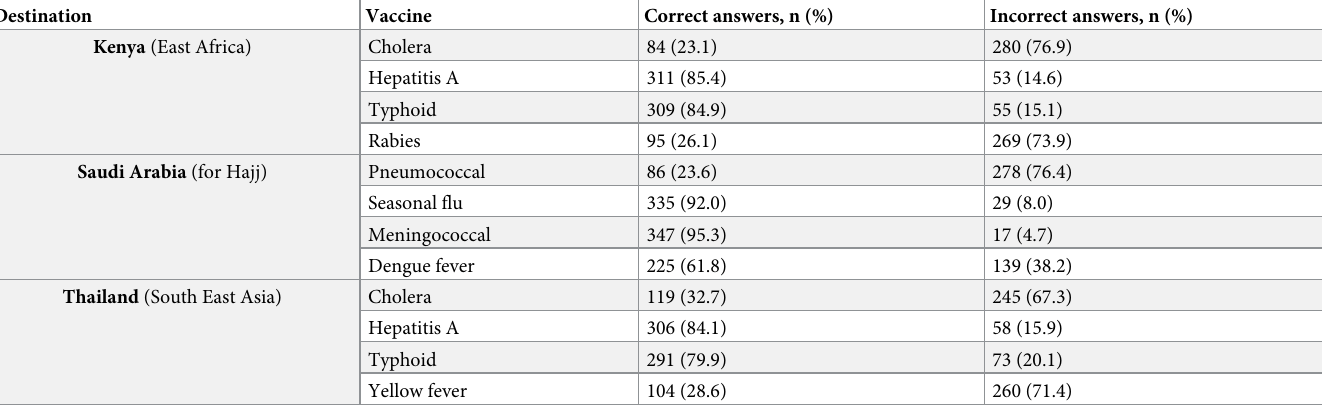
Table 2. Primary care physicians’ knowledge of vaccine recommendation for most adults travelling to frequent destinations from Qatar (N = 364). Destination